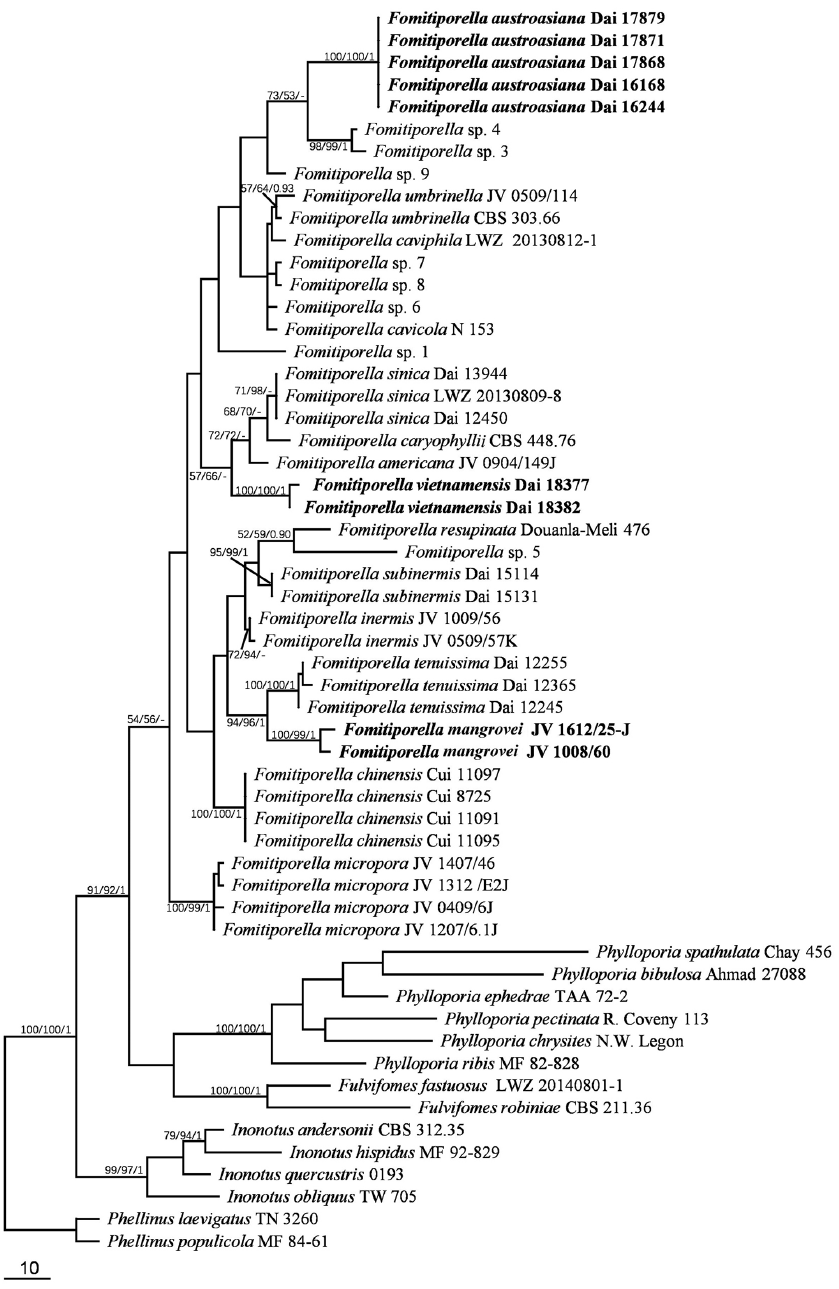
Figure 1. Phylogeny of Fomitiporella inferred from the 28S dataset. The topology is that of the MP analysis, and statistical values (ML/MP/BI) are indicated for each node that simultaneously received BS from ML and MP not below 50 %, and BPP from BI not below 0.9. Phellinus laevigatus and P. populicola are used to root the tree. Branch lengths reflect the number of steps as indicated by the